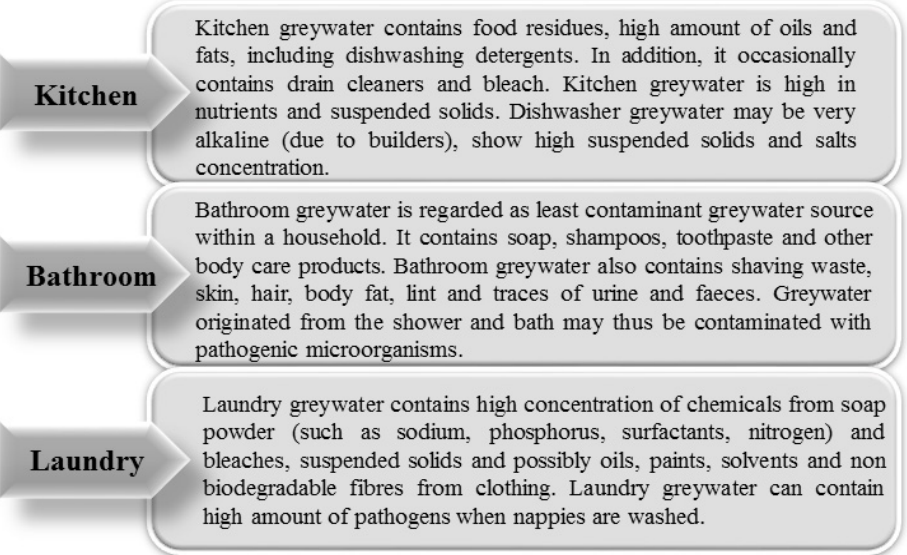
Table 1. Greywater generation reported in different